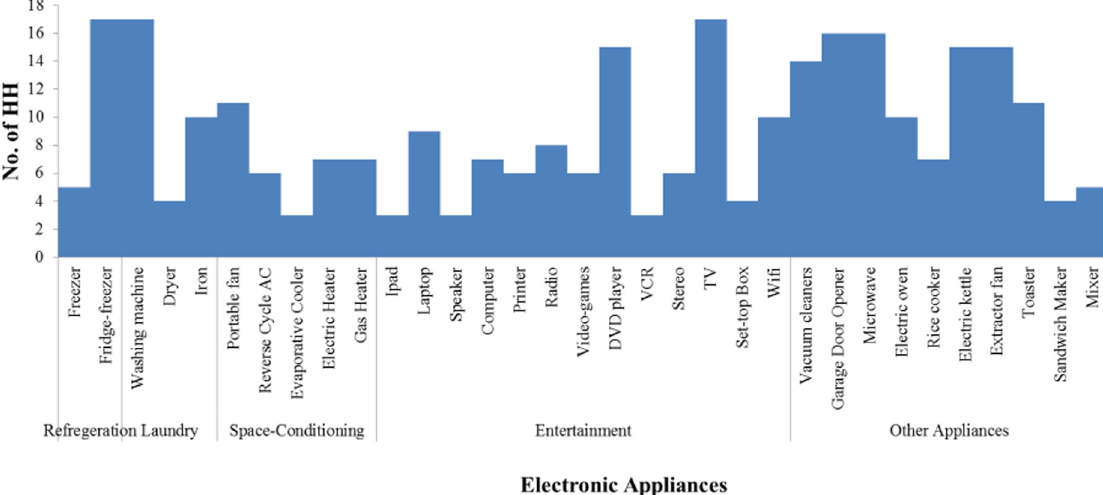
Fig. 5. Different appliances used in the sample